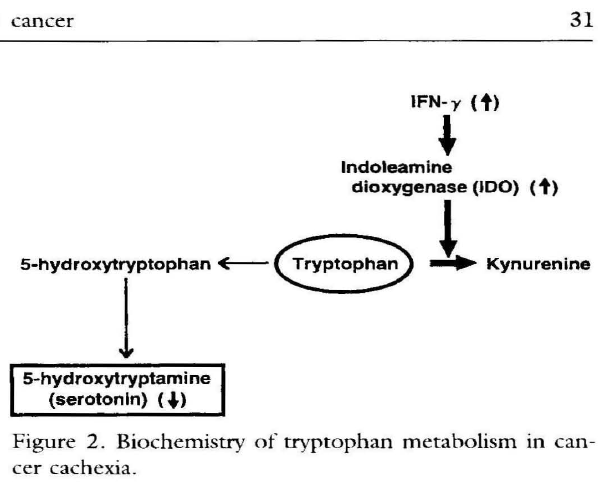
Figure 2 . Biochemistry of tryptophan metabolism in can cer